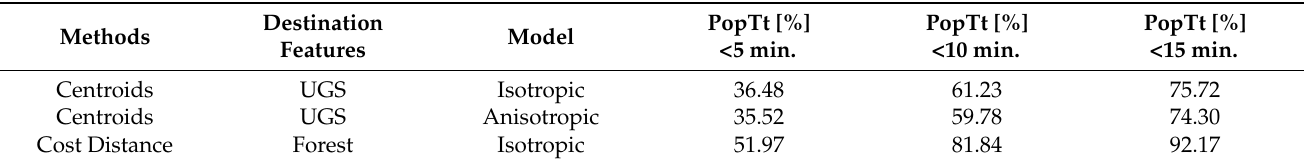
Table 3. Percentage of population that have access by walking and motorization to a green space or forest patch within a maximum travel time (PopTt), using different methods.